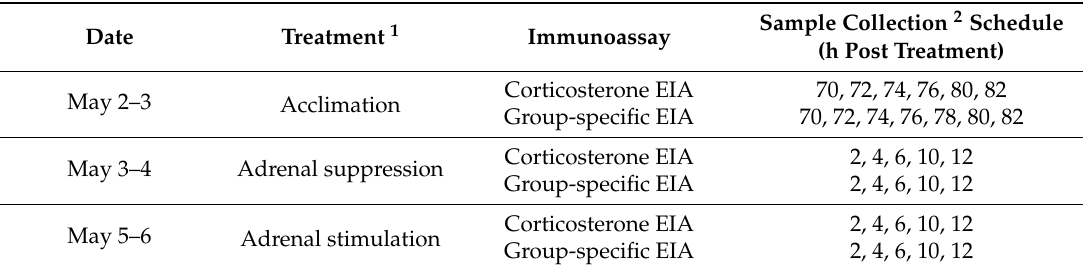
Table 1. Timeline of treatments and samples used in statistical analyses for evaluation of fecal corticosterone metabolites in